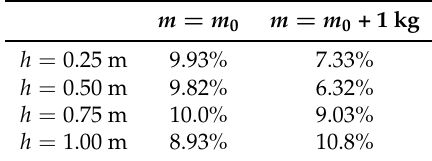
Table 2. Percent error on the displacement of the center of mass of the buoyant cylinder as a function of h and m